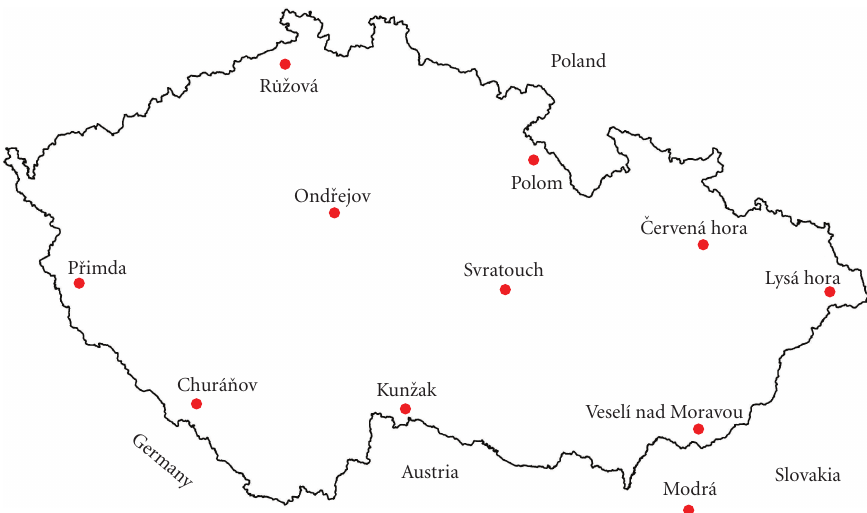
Figure 1: Location of the station within the Czech fireball network (Image courtesy of Pavel Spurn´y).